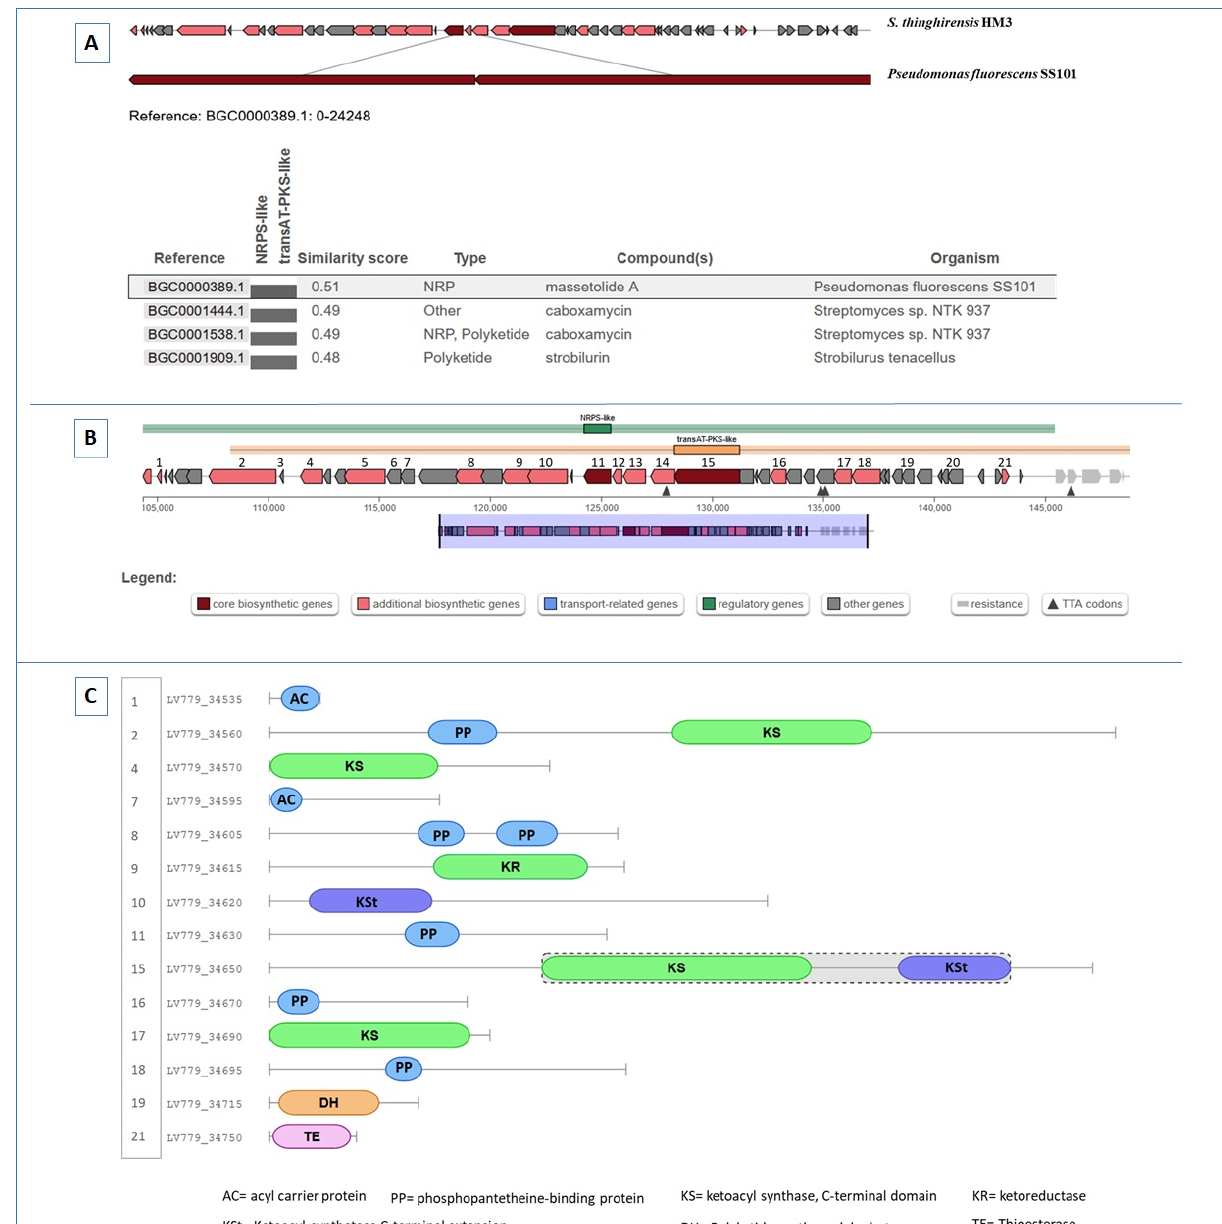
Figure 6. NRPS-like fragment/transAT-PKS-like biosynthetic gene cluster in S. thinghirensis HM3. ( A ) The comparison between the proposed NRPS-like fragment/transAT-PKS-like gene cluster in strain HM3 and the proposed identified cluster of massetolide A and caboxamycin in Pseudomonas fluorescens SS101 and Streptomyces sp. NTK 937 had a similarity score reaching 0.51 and 0.49 at MIBiG website. ( B ) The proposed NRPS-like fragment/transAT-PKS-like gene cluster in region 59.2 of strain HM3 genome; 3, KR domain-containing protein; 5, hypothetical protein; 6, 14, condensation domain; 12, 13, AMP-binding protein; 20, polyketide synthase. ( C ) represents the domains involved in NRPS-like fragment/transAT-PKS-like biosynthesis based on Pfam. As for PKS BGCs, two clusters related to type II PKS were identified by antiSMASH. The first cluster existed in region 15.1 and exhibited 8% and 19% shared sequences with xantholipin (a polycyclic xanthone antibiotic with antimicrobial and antitumour activities) from Streptomyces flavogriseus , and mensacarcin (a potential antitumour drug) from Streptomyces bottropensis , when compared with KnownClusterBlast. The second type II PKS BCG spanned 44,648 to 107,146 (with approximately 62.5 kb in region 44.1). Retrieved